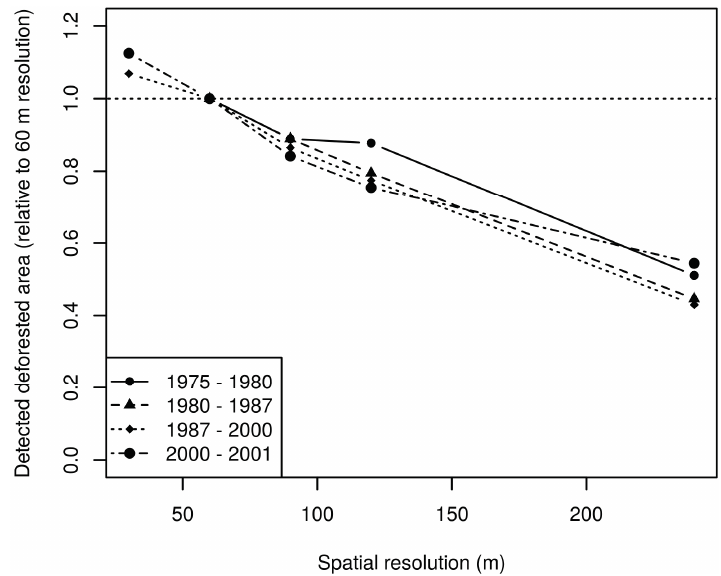
Figure 9. Detected deforested area (relative to 60 m resolution) in the periods 1975–1980, 1980–1987, 1987–2000, and 2000–2001 at different spatial